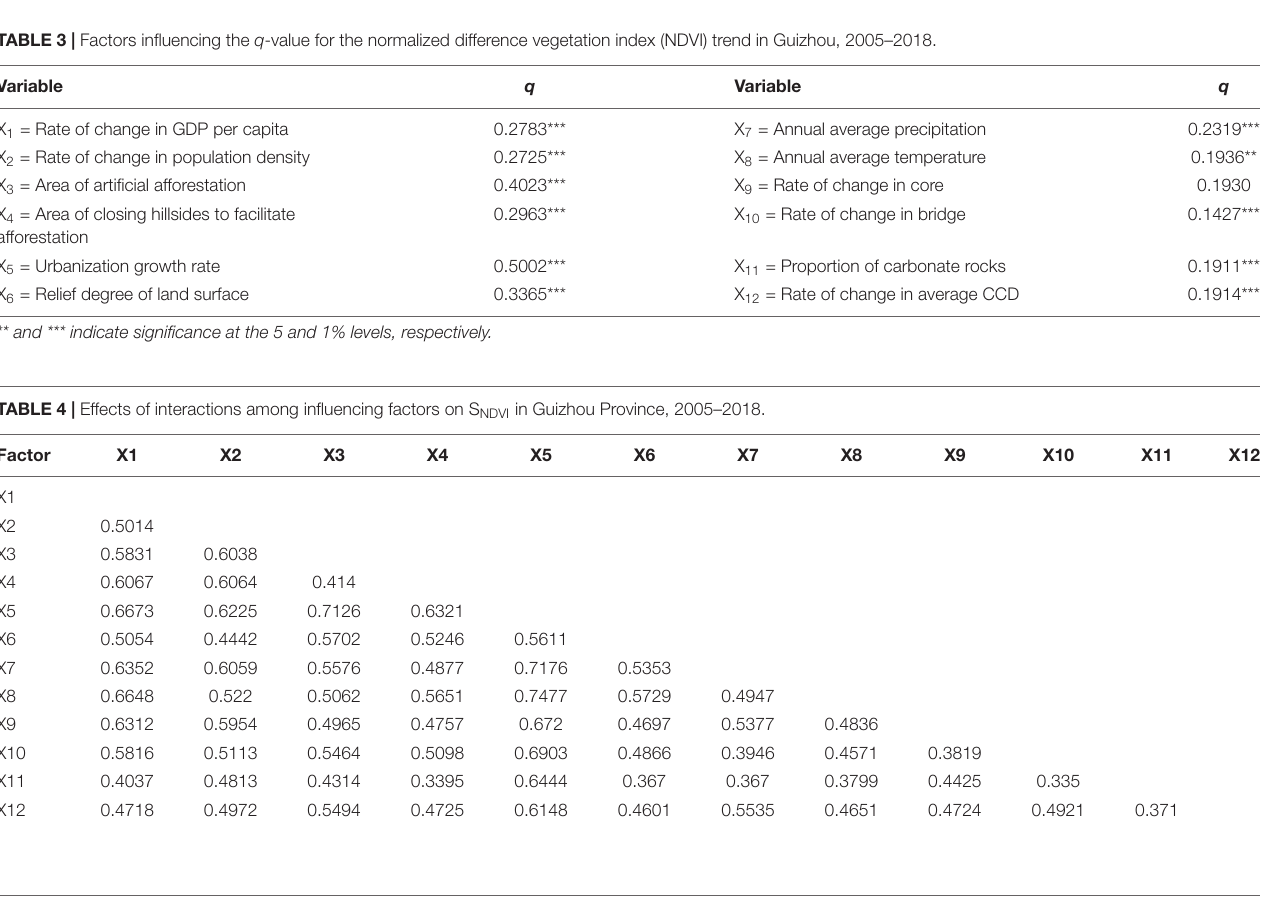
FIGURE 7 | Correlation analysis of average cumulative current density (CCD) and normalized difference vegetation index (NDVI) in counties with different geomorphic forms.